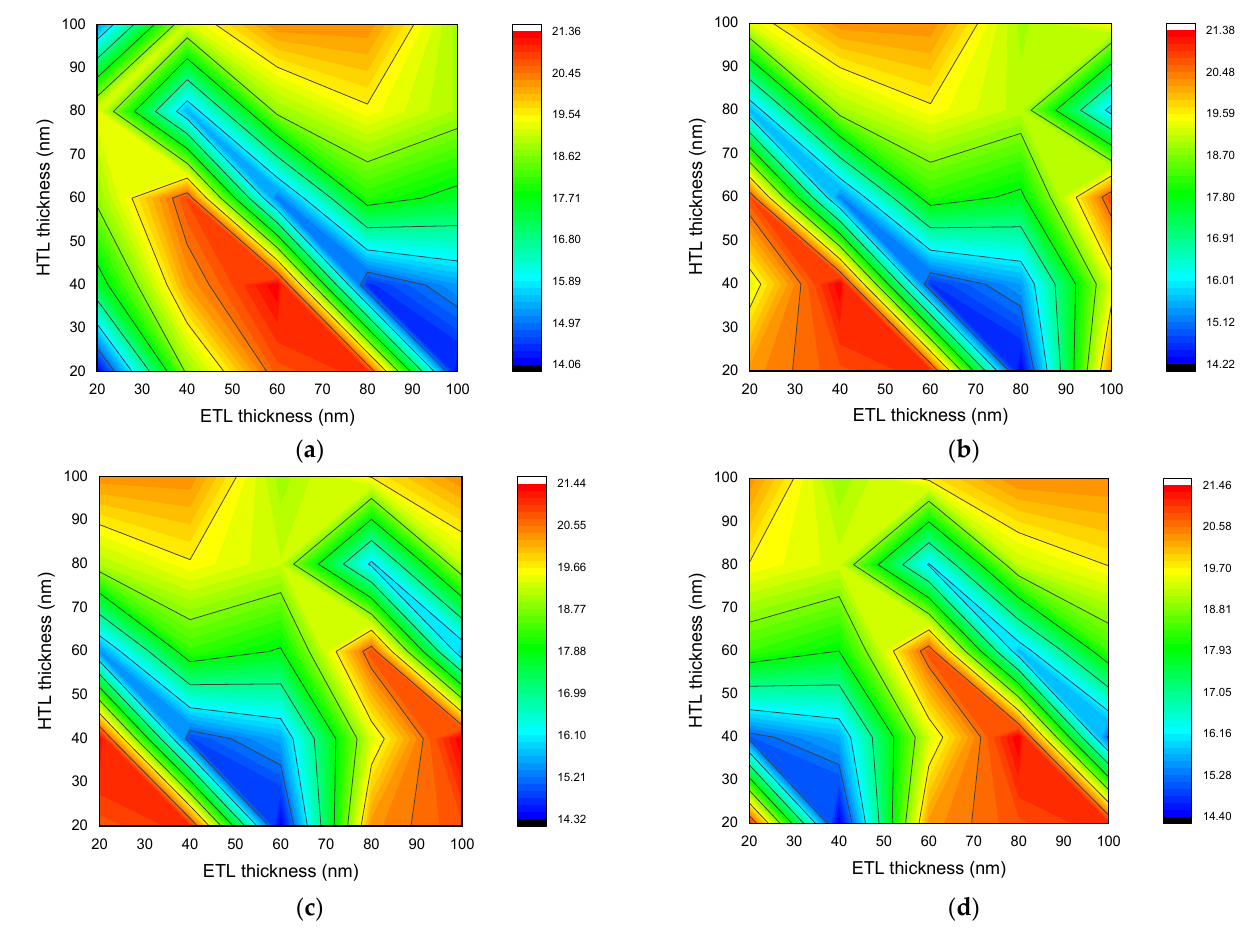
Figure 4. Dependence of short-circuit current of n-ZnO/p-CH 3 NH 3 PbI 3 /p-NiO x solar cell with perovskite layer thickness of 200 nm ( a ), 400 nm ( b ), 600 nm ( c ), and 800 nm ( d ) on ETL and HTL layer thicknesses.